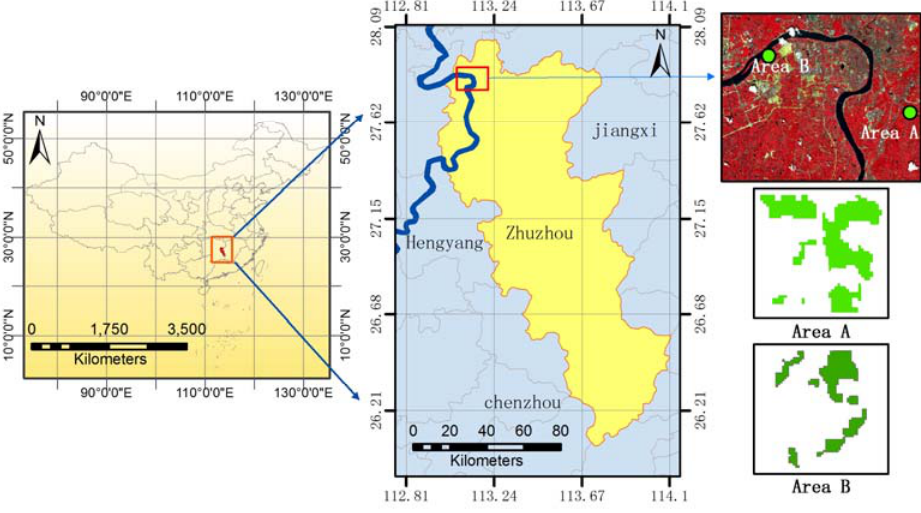
Figure 1. Location of the study areas in the city of Zhuzhou, Hunan Province, China.